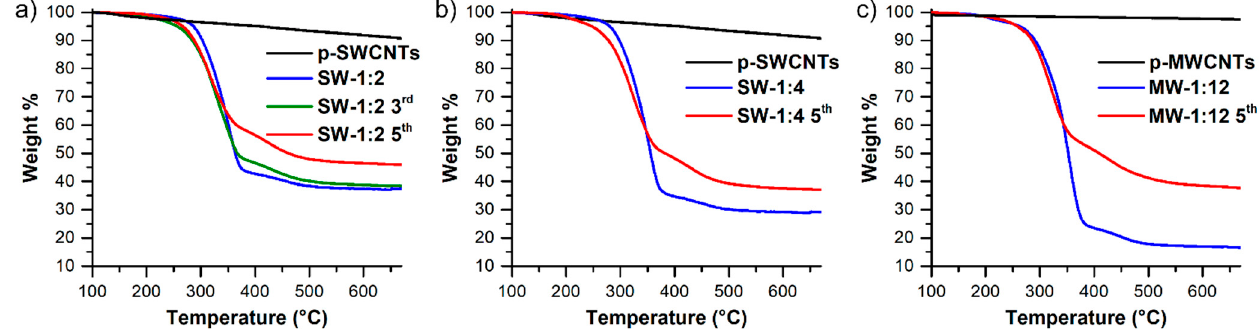
Figure 4. TGA analysis of ( a ) fresh and reused SW-1:2, ( b ) fresh and reused SW-1:4, ( c ) fresh and reused MW-1:12.